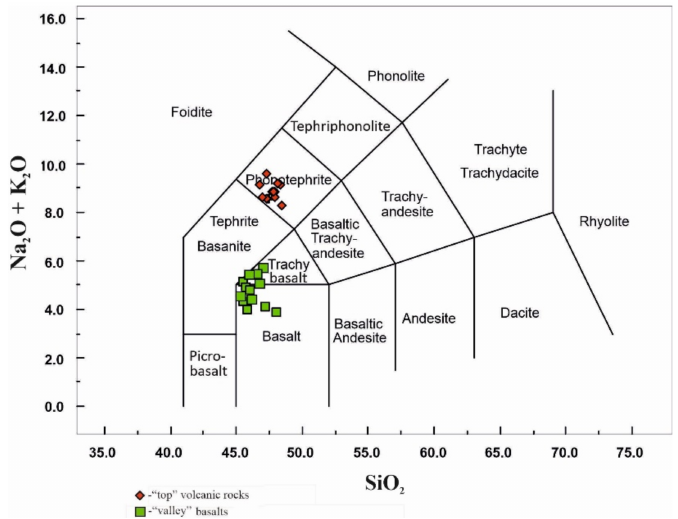
Figure 11. Chemical composition of volcanic rocks, fields according to [21]. Petrochemical data show that the Naryn-Gol placer volcanic rocks are calc-alkaline and rich in K (Figure 12), which is typical of continental rift volcanic rocks. The “top” volcanic rocks have a higher K 2 O concentration varying from 2.5 to 4 wt. %, while the “valley” rocks contain only 1 to 2 wt. %. Based on the obtained results, we constructed an AFM-diagram showing that volcanic rocks of the Naryn-Gol region belong to the calc-alkaline series (Figure 12).